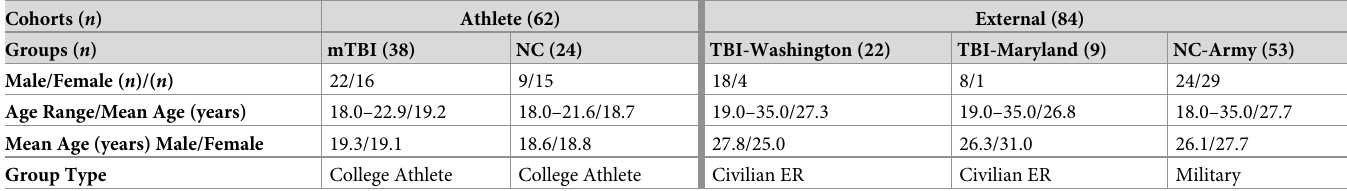
Table 1. Collegiate Athlete cohort and external validation cohort